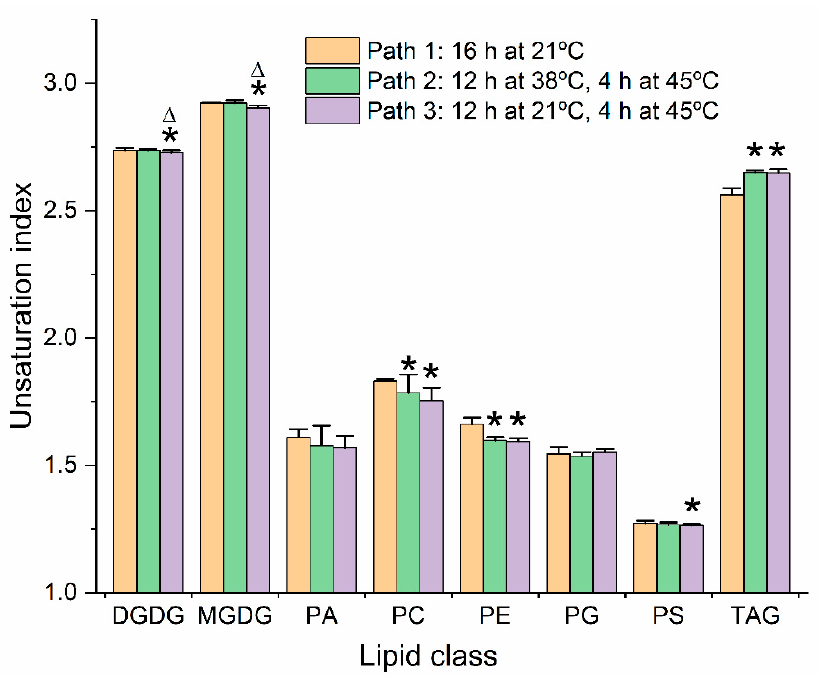
Figure 8. Unsaturation indices of control and heat-treated diacyl lipid species from leaves of wild-type Arabidopsis thaliana. Unsaturation indices indicate the average number of double bonds per acyl chain in each lipid class, calculated as described in Materials and Methods. Comparisons were made at the 16 h time point for control plants (Path 1, orange bars), plants treated for 12 h at 38 °C followed by 4 h at 45 °C (Path 2, green), and 12 h at 21 °C followed by 4 h at 45 °C (Path 3, lavender). Asterisks indicate significant differences from that of the Path 1 control plants ( p < 0.05) by one-way ANOVA, with Tukey’s multiple comparisons test, adjusted for FDR. Triangles indicate that a Path 3 value is significantly different than a Path 2 value. Error bars indicate standard deviation.